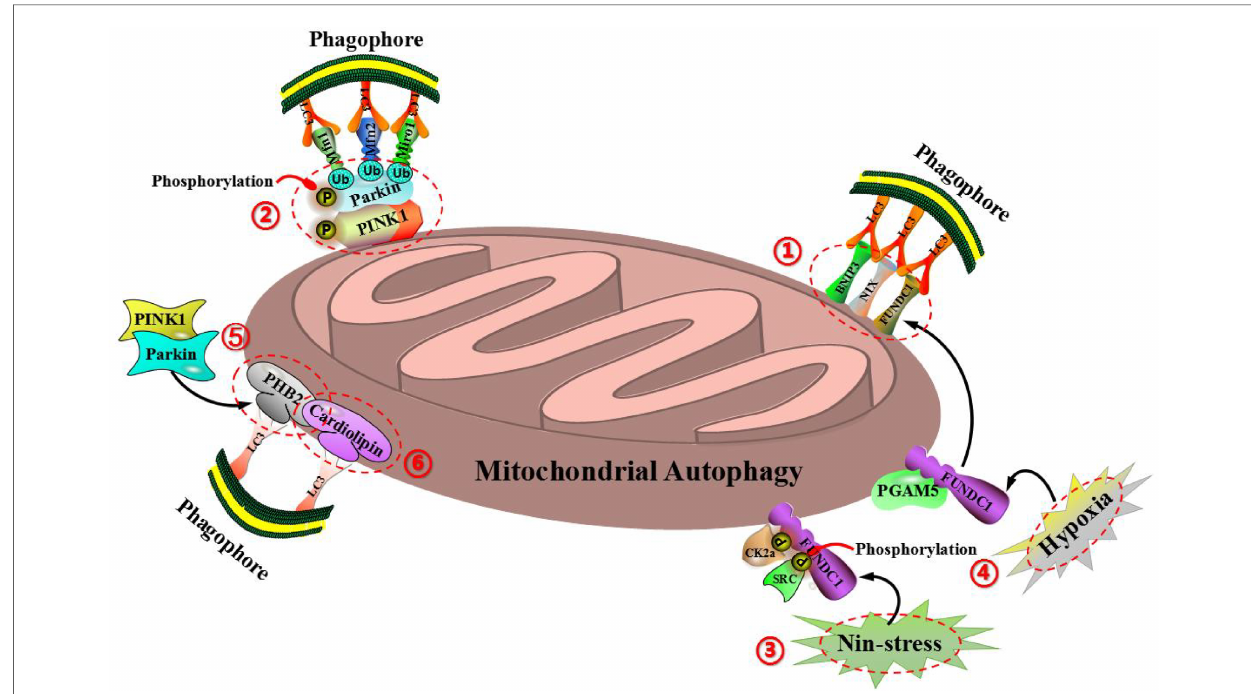
FIGURE 3 Molecular mechanism of mitochondrial autophagy regulation can be divided into two types: ubiquitin-dependent mitochondrial autophagy (including PINK1 and Parkin) and ubiquitin-independent mitochondrial autophagy (including BNIP3, NIX, FUNDC1, PHB2, cardiolipin and so on). (1) BNIP3, FUNDC1, and NIX are all located on the outer membrane of mitochondria and can bind directly to LC3-mediated mitochondrial autophagy via the domain of LC3 interaction (LIR). (2) BNIP3 can also inhibit the proteolysis of PINK1, so as to cause the accumulation of PINK1 on the outer mitochondrial membrane, thereby promoting PINK1/Parkin-mediated mitochondrial autophagy. (3) Under the condition of non-stress, FUNDC1 is phosphorylated by protein kinase CK2 α in the region of Ser-13 and phosphorylated by protein kinase SRC in the region of Tyr-18, so as to inhibit the interaction of LC3 with FUNDC1, thereby preventing the occurrence of mitochondrial autophagy. (4) Under the condition of mitochondrial membrane potential loss or hypoxia, protein phosphatase PGAM5 can interact with FUNDC1 to prevent CK2 α and SRC kinase to combin with FUNDC1, resulting in the dephosphorylation of FUNDC1, so as to enhance the interaction between FUNDC1 and LC3, and induce mitochondrial autophagy. (5) As an important receptor for mitochondrial autophagy, the inner mitochondrial membrane protein PHB2 can mediate mitochondrial autophagy via the domain of LIR, and bind to the autophagic membrane-related protein LC3 during the process of mitochondrial depolarization and proteasome-dependent outer membrane rupture, which is closely associated with the PINK1/Parkin signaling pathway. (6) Cardiolipin (CL), as a phospholipid in the inner mitochondrial membrane, can be externalized to the outer mitochondrial membrane when mitochondria are damaged, while the redistribution of CL and its interaction with LC3 initiate a signaling cascade and mediate mitochondrial